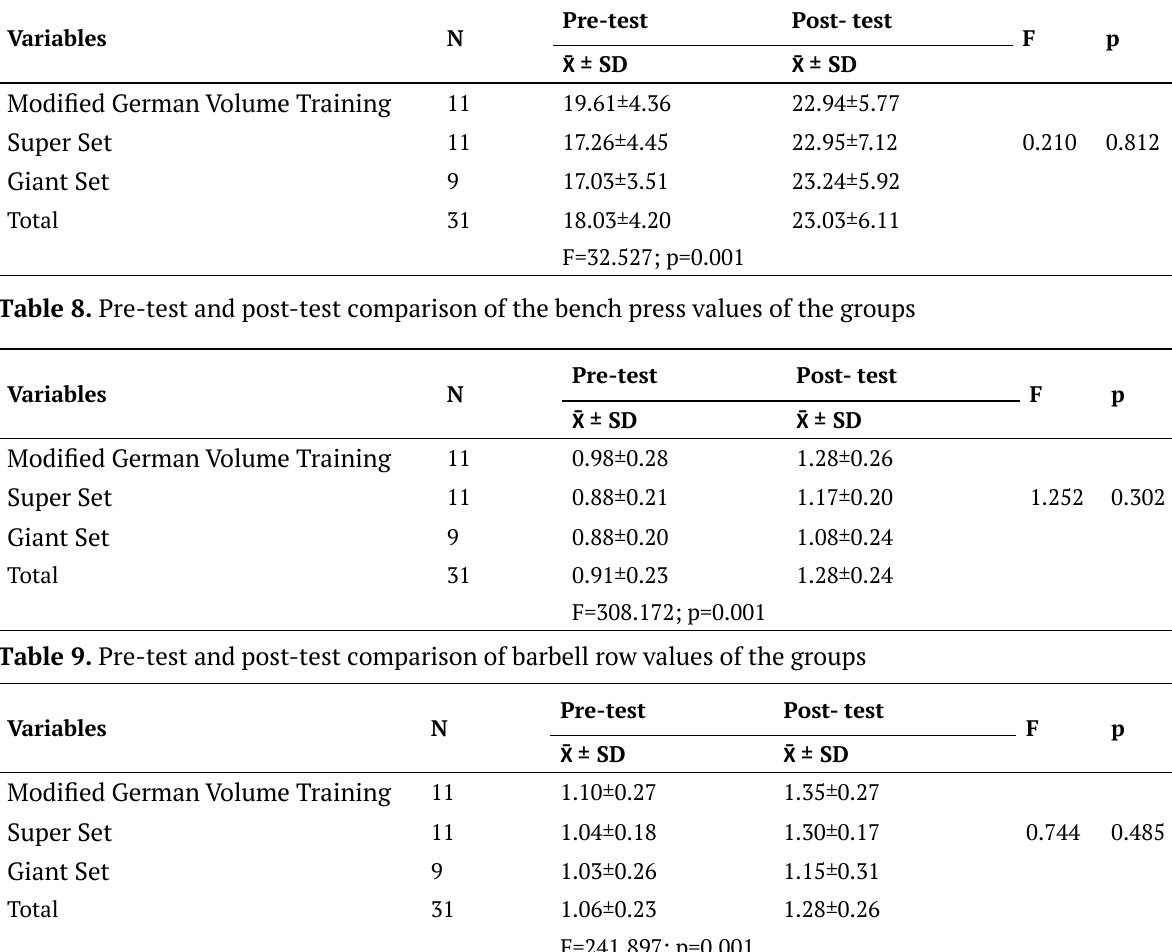
Table 7. Pre-test and post-test comparison of the latissimus area values of the groups